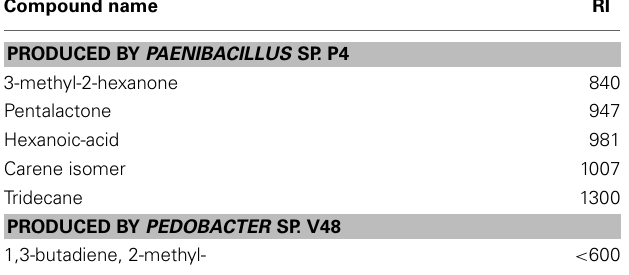
Table 1 | Volatile organic compounds produced by 4 bacterial strains growing in sterile sand containing artificial root